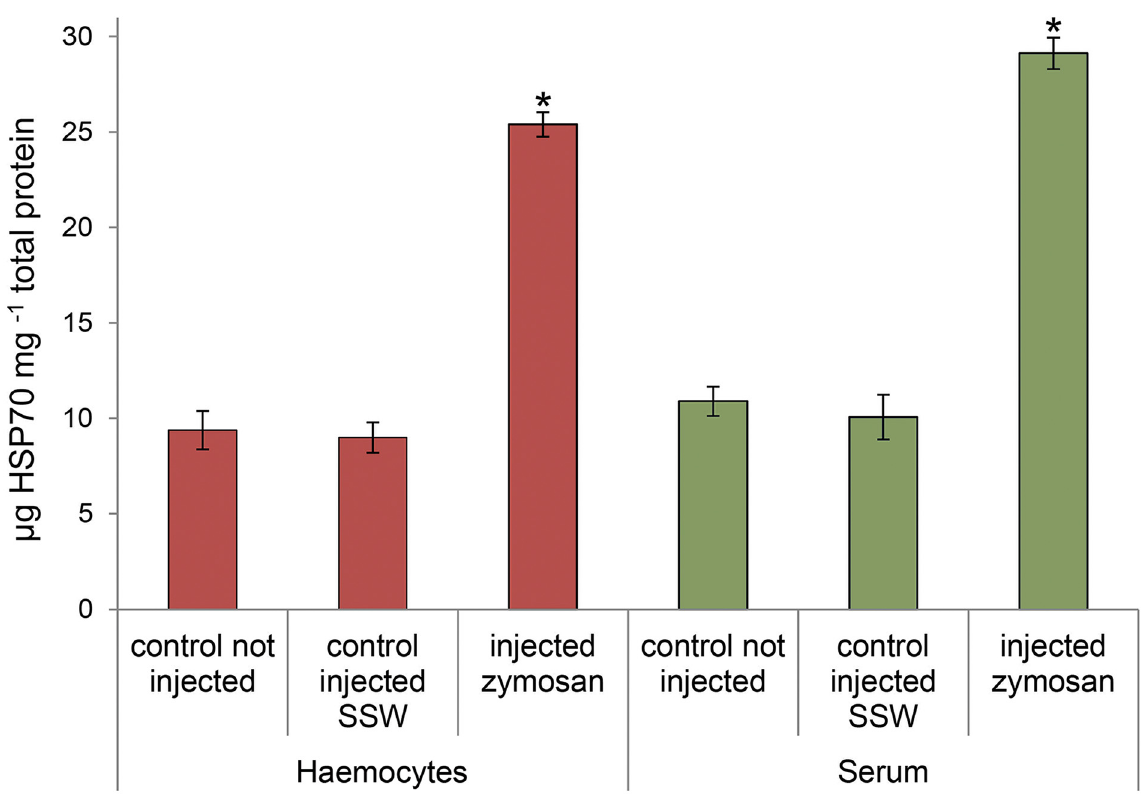
Fig 1. Induced levels of HSP70 in haemocytes and serum of challenged red abalone Haliotis rufescens . HSP70 levels were measured in the intracellular (haemocytes) and extracellular (serum) fractions of H . rufescens , in individual not injected (i.e., injection control), injected with sterilized sea water (SSW) (i.e., challenge control) and injected with the β -glucan, zymosan (24-h post-injection). The data are shown as X ± S.E., n = 6 – 10 per condition. ( * ) indicates significance ( P < 0.01) between treatment and controls at the indicated haemolymph fraction.